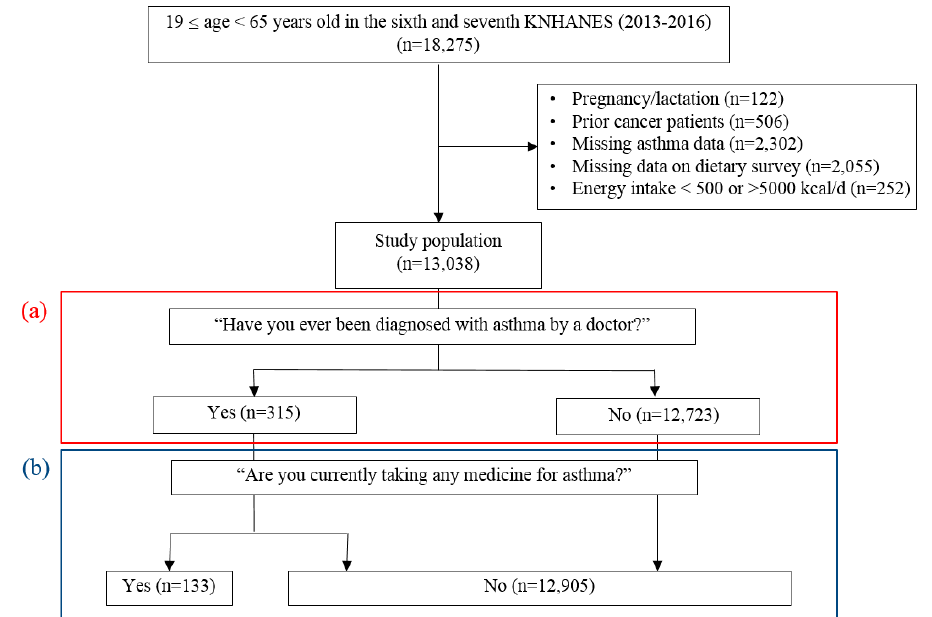
Figure 1. Flow chart of study population selection and the inclusion and exclusion criteria. ( a ) doctor-diagnosed asthma; ( b ) medication prescribed asthma.